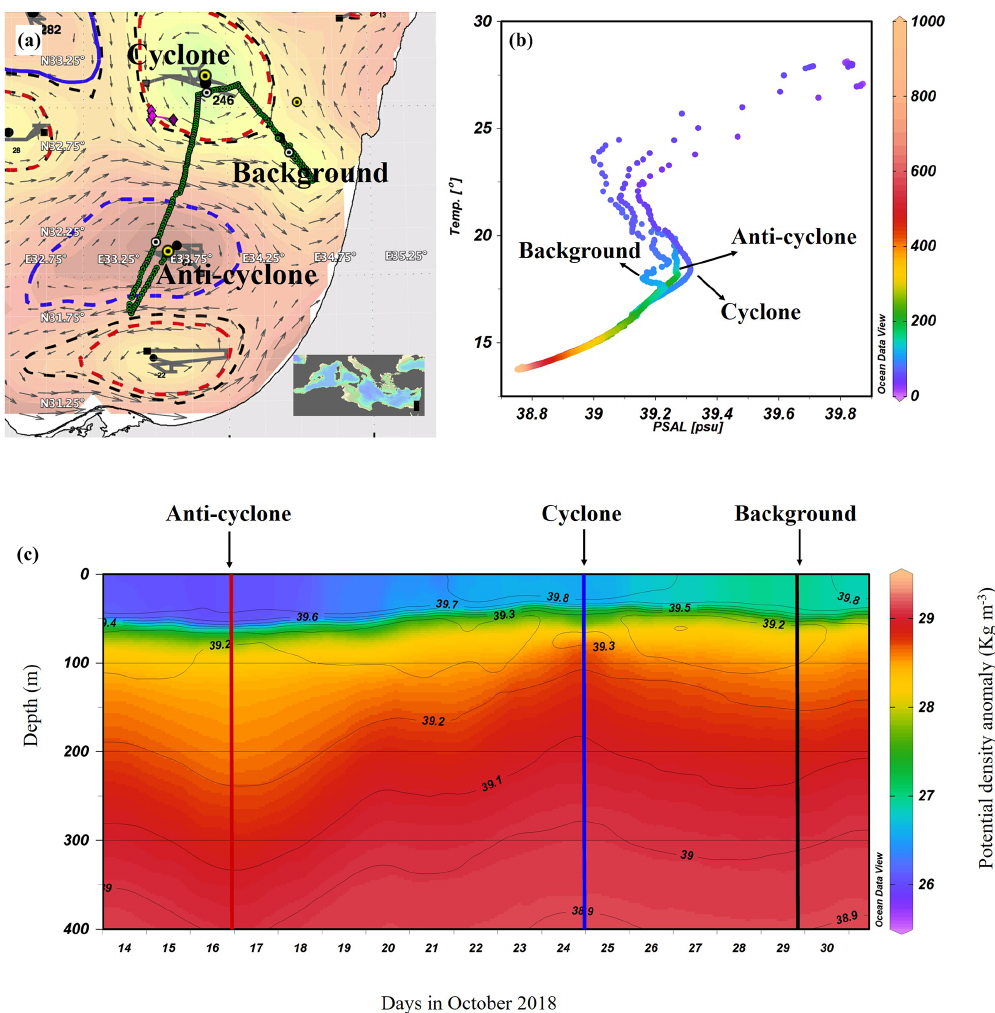
Figure 1. Altimetry map with eddies detected by the AMEDA algorithm created on the morning of the cruise (9 October 2018): sampling stations (yellow marks) and a glider cruise track (green dots) (a) , temperature–salinity ( T – S ) diagram of the stations sampled (b) , and the potential density anomaly derived from a glider mission (292 quasi-vertical profiles) held a few days after the cruise (13–31 October 2018) (c) . Contours on the density map show the corresponding